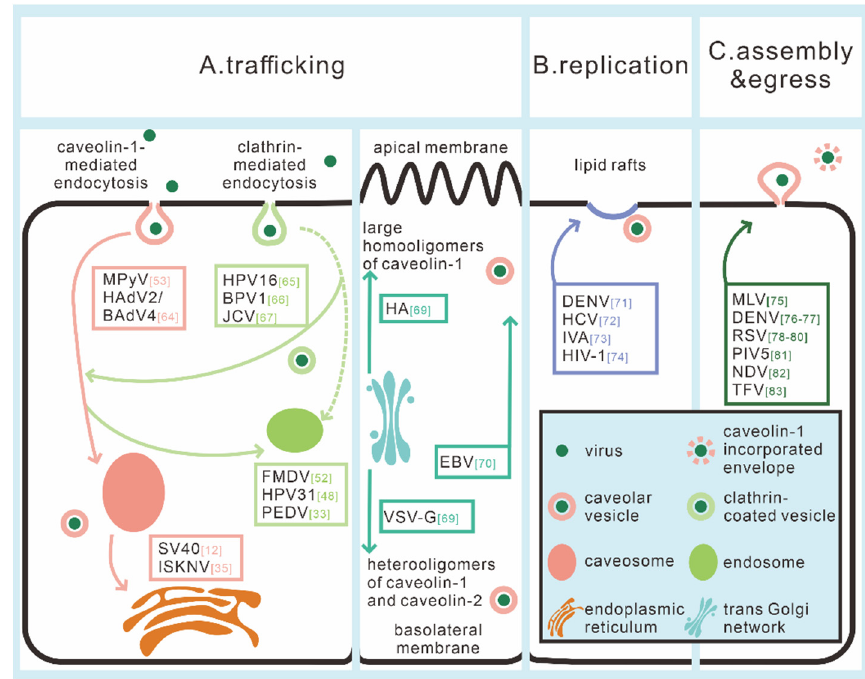
Figure 2. Multifunctional roles of caveolae/CAV-1 in the life cycle of corresponding viruses. ( A ) Trafficking: CAV-1 is involved in the complicated trafficking network of viruses. There is host cell type-, virus type-dependent crosstalk between caveosome trafficking and endosome trafficking, despite different endocytic pathways (caveolae- or clathrin-mediated) that viruses hijack. In addition to viral particles, CAV-1 is also involved in regulating the sorting and transport of viral components/proteins. ( B ) Replication: caveolae and CAV-1 facilitate the targeted location of virions, viral proteins, and host-related proteins to lipid rafts-associated compartments to complete viral replication. ( C ) Assembly and egress: caveolae and CAV-1 are involving in virus release and might incorporate into the enveloping process of some mature virus particles. The chromatic wireframes indicate the reported viruses involved in these processes. Numbers in square brackets indicate the relative references.